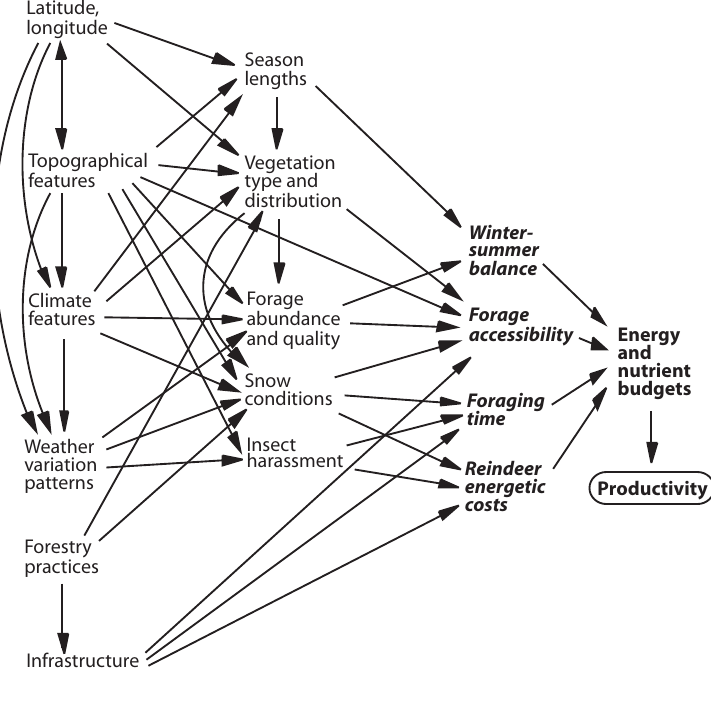
Fig. 2. Conceptual overview of factors suggested to affect reindeer